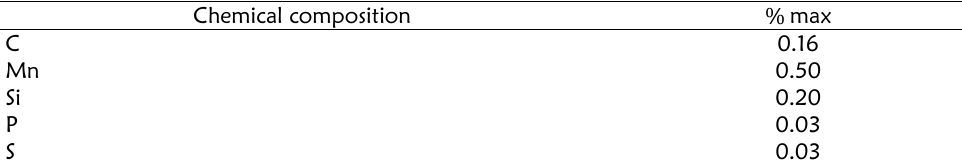
Table 2: Chemical composition of LPG cylinders